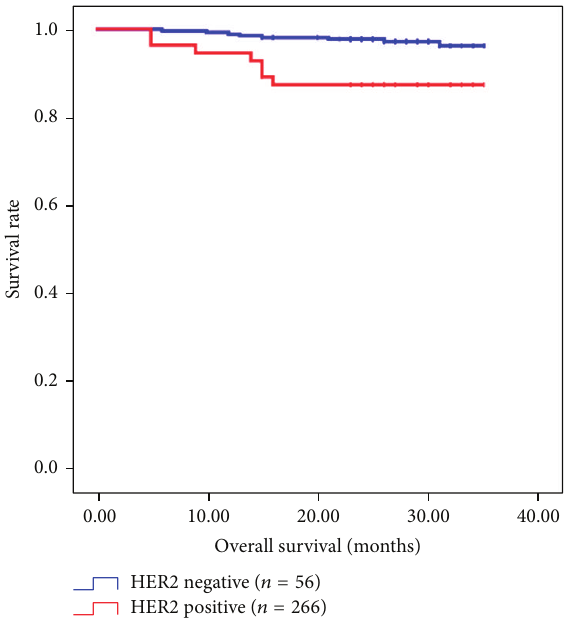
Table 3: Univariate and multivariate analysis of clinicopathological variables for the survival of the patients with gastric carcinoma. Figure 2: Kaplan-Meier survival curves according to the HER2 overexpression in patients with gastric